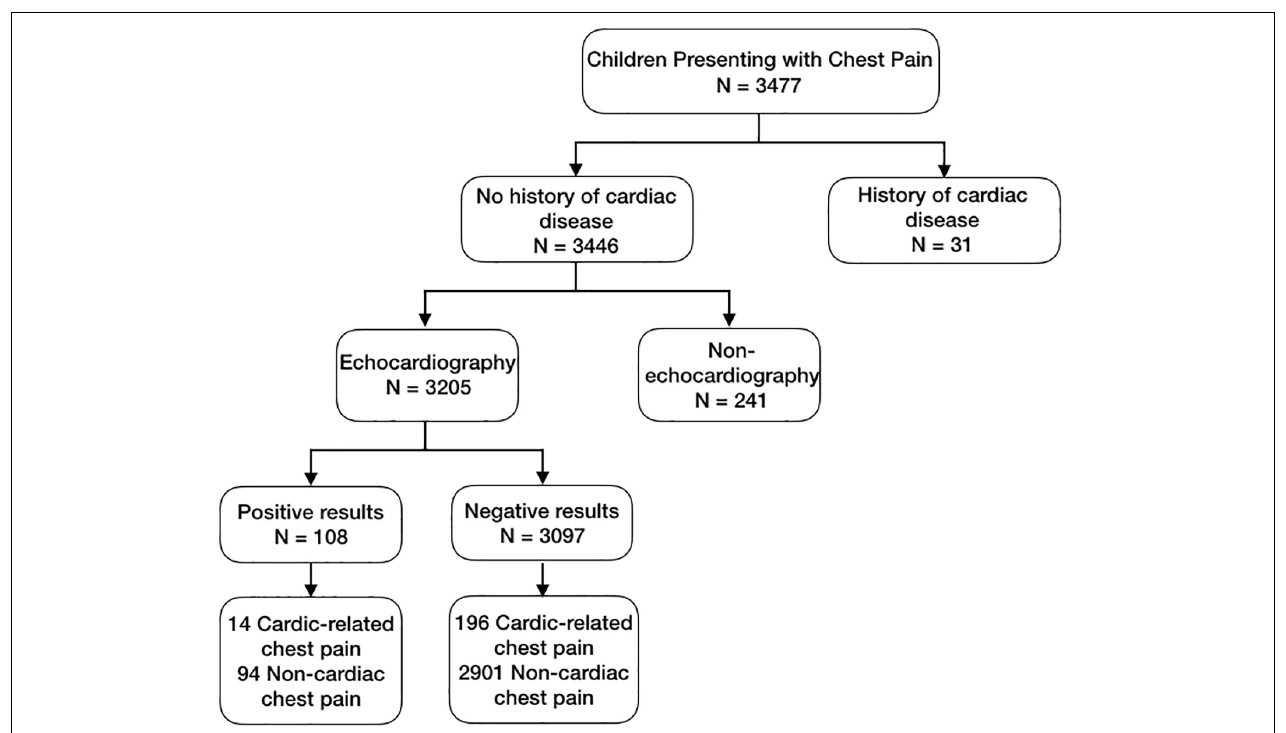
FIGURE 3 | Profile of screening cardiac chest pain study by echocardiography.